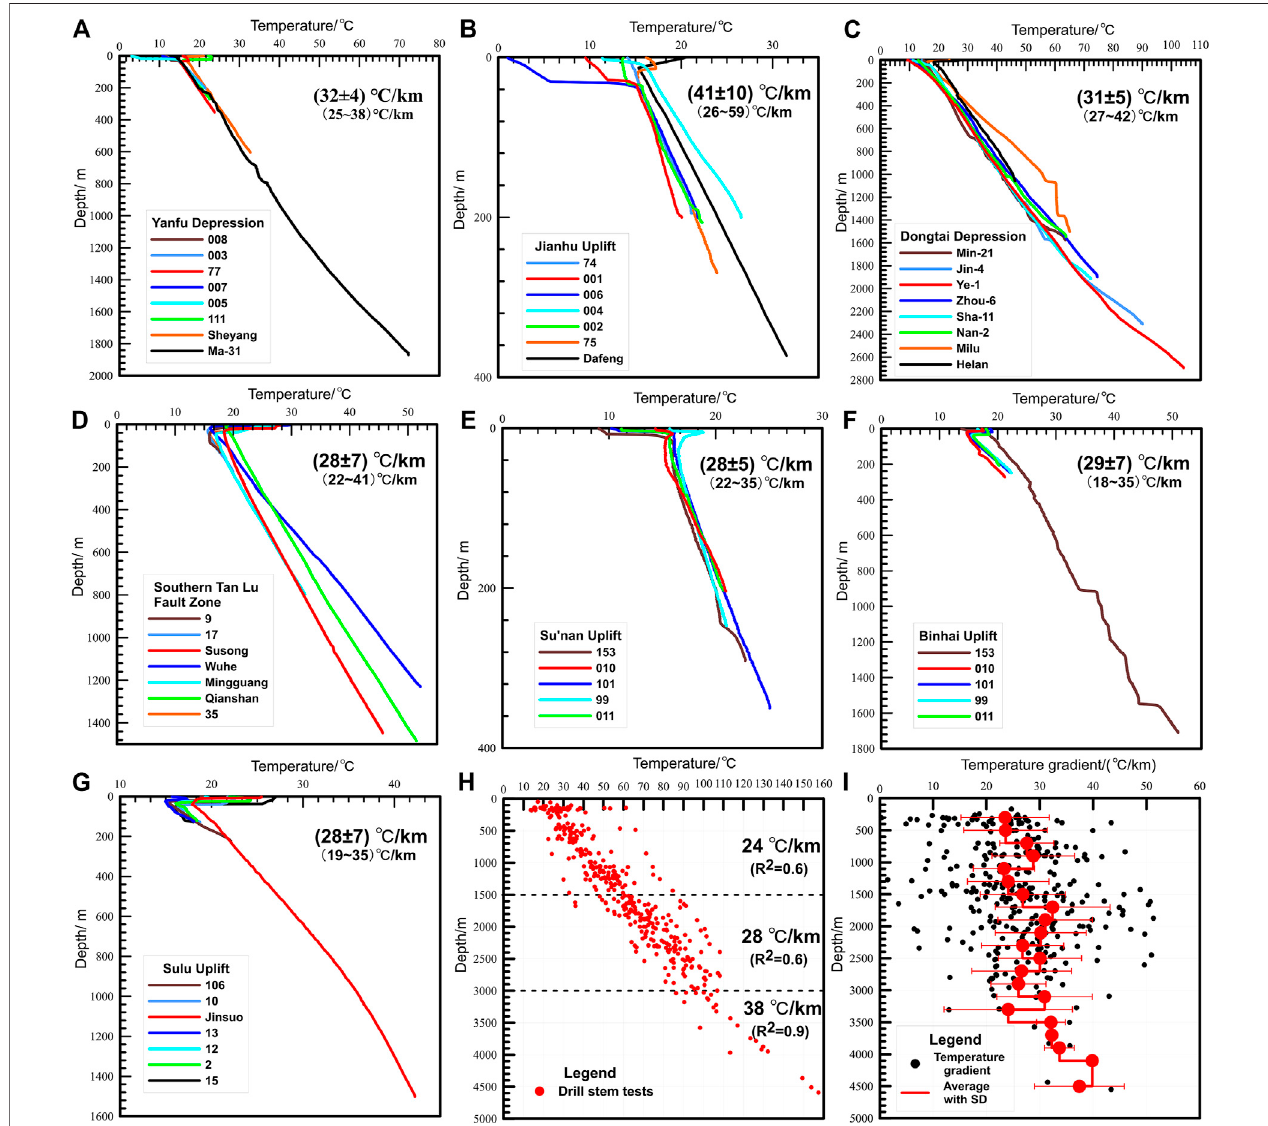
FIGURE3| Thenewdrillstemtestsdata,temperaturegradient,andtemperature-depthpro fi lesforthemeasuredboreholesineachsub-structuralunitoftheNorth Jiangsu Basin and its adjacent areas.